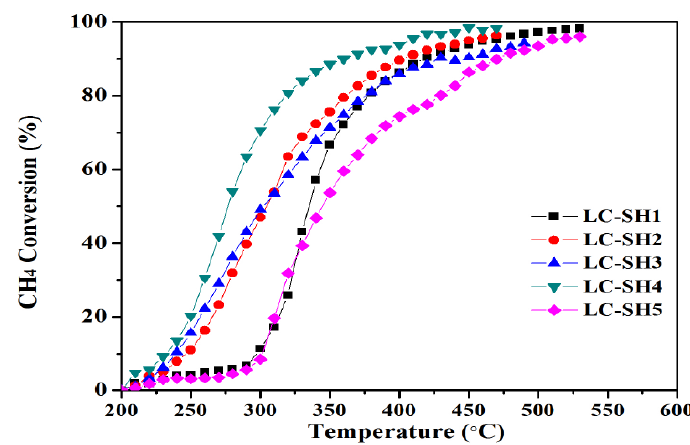
Figure 2. Effects of different amounts of nitrogen on catalytic activity of catalysts.